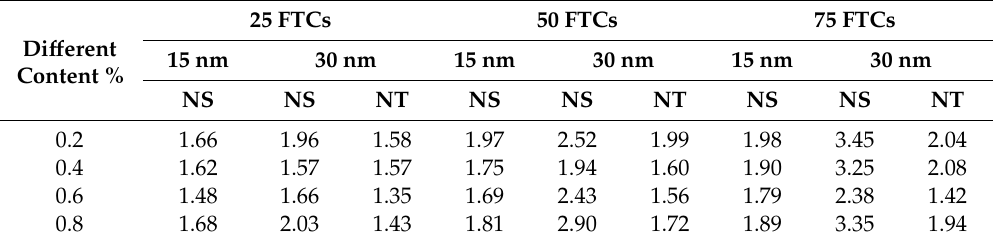
Table 7. The internal porosity of nano-particle added concrete under different FTCs (%).